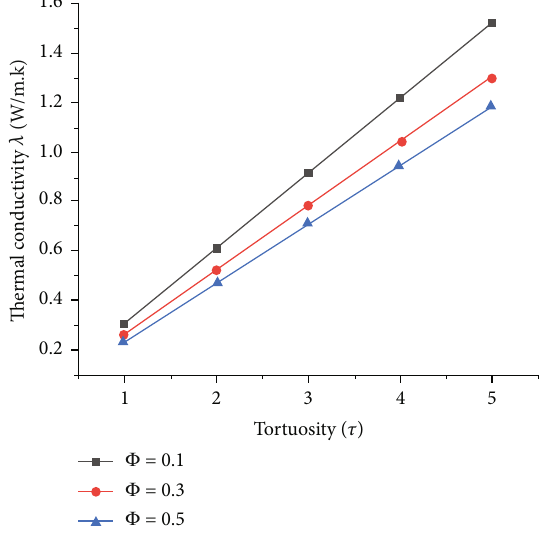
Figure 15: Relationship between thermal conductivity λ and tortuosity τ of the detailed volume-weighted average REV model with di ff erent porosity φ